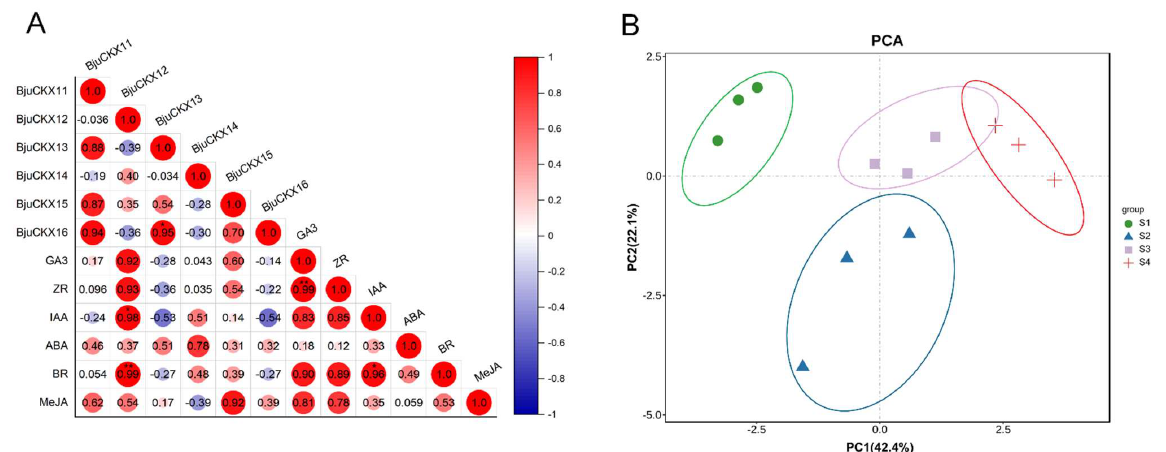
Figure 9. ( A ) Correlation analysis between BjuCKX genes and six hormones. ( B ) Principal Component Analysis (PCA) plot of mustard in four developmental periods. Note: * means significant differences at 0.05 level; ** mean significant differences at 0.01 level.